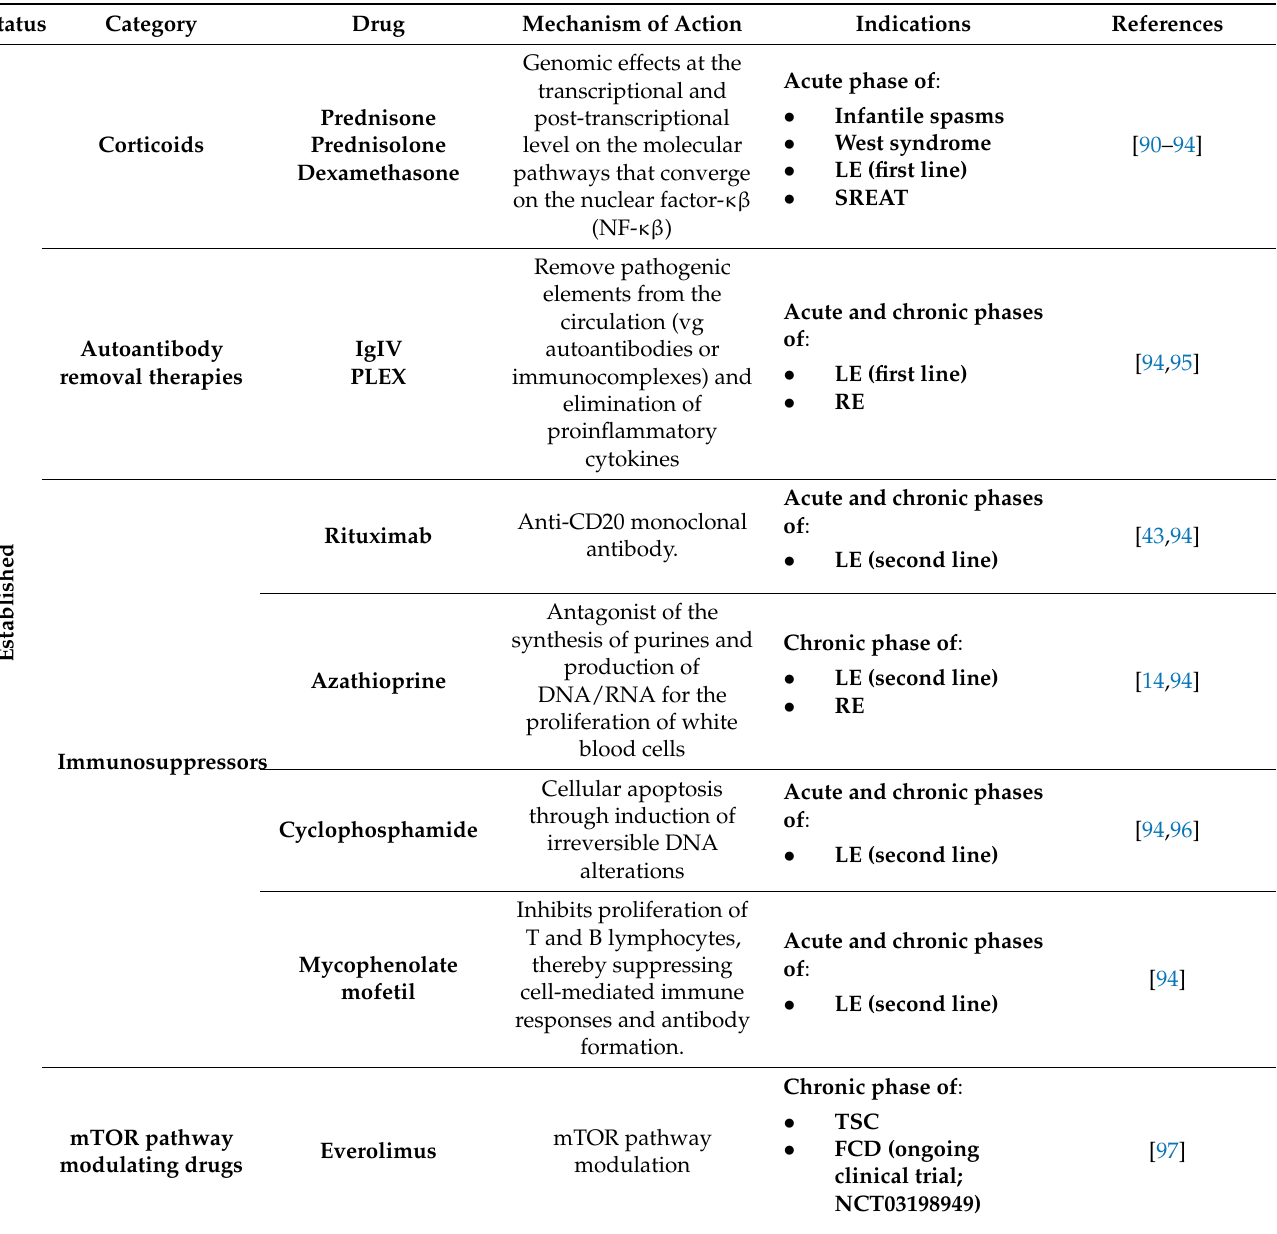
Table 3. Main therapeutic lines according to the degree of development in clinical research. Those drugs that have some study related to epilepsy are marked with an asterisk